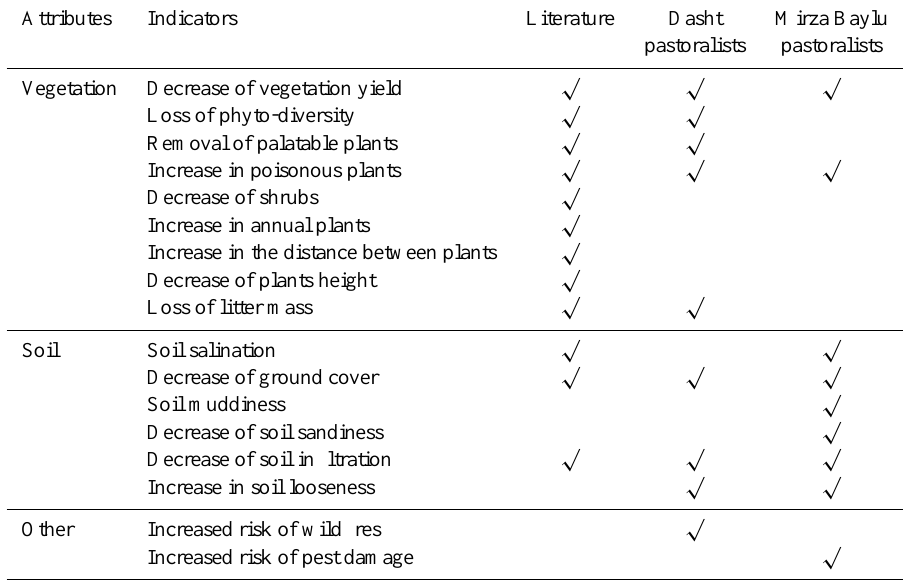
Table 1. Identified rangeland degradation indicators based on literature and indigenous ecological knowledge. Indicators related to each category are shown with a check